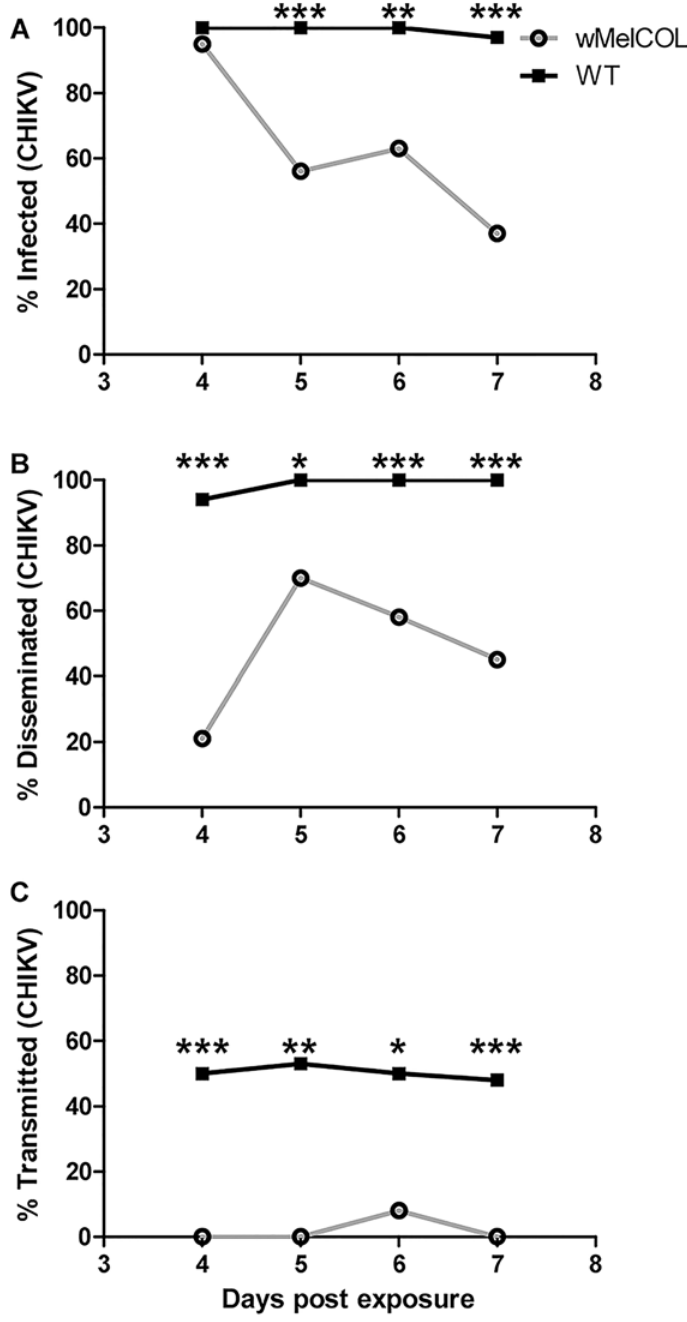
Fig 2. Infection dynamics through time for WT (black line) and wMelCOL mosquitoes (gray line) orally infected with 9.00 log 10 PFU/ml of CHIKV. Mosquitoes were examined at days 4 – 7 to determine infection, dissemination, and transmission efficiencies. Infection efficiency corresponds to the proportion of mosquitoes with virus-infected bodies among the tested ones. Dissemination efficiency corresponds to the proportion of mosquitoes with virus-infected legs, and transmission efficiency corresponds to the proportion of mosquitoes with infectious saliva among those infected. * , significant reduction in infection rates ( * p < 0.05, ** p < 0.01, *** p < 0.001). A). Percent infected (4d, n = 20 for w MelCOL and n = 18 for WT; 5d, n = 18 for w MelCOl and n = 19 for WT; 6d, n = 19 for w MelCOL and n = 14 for WT; 7d n = 30 for w MelCOL and WT. B). Percent disseminated (of infected). C.) Percent transmitting (of